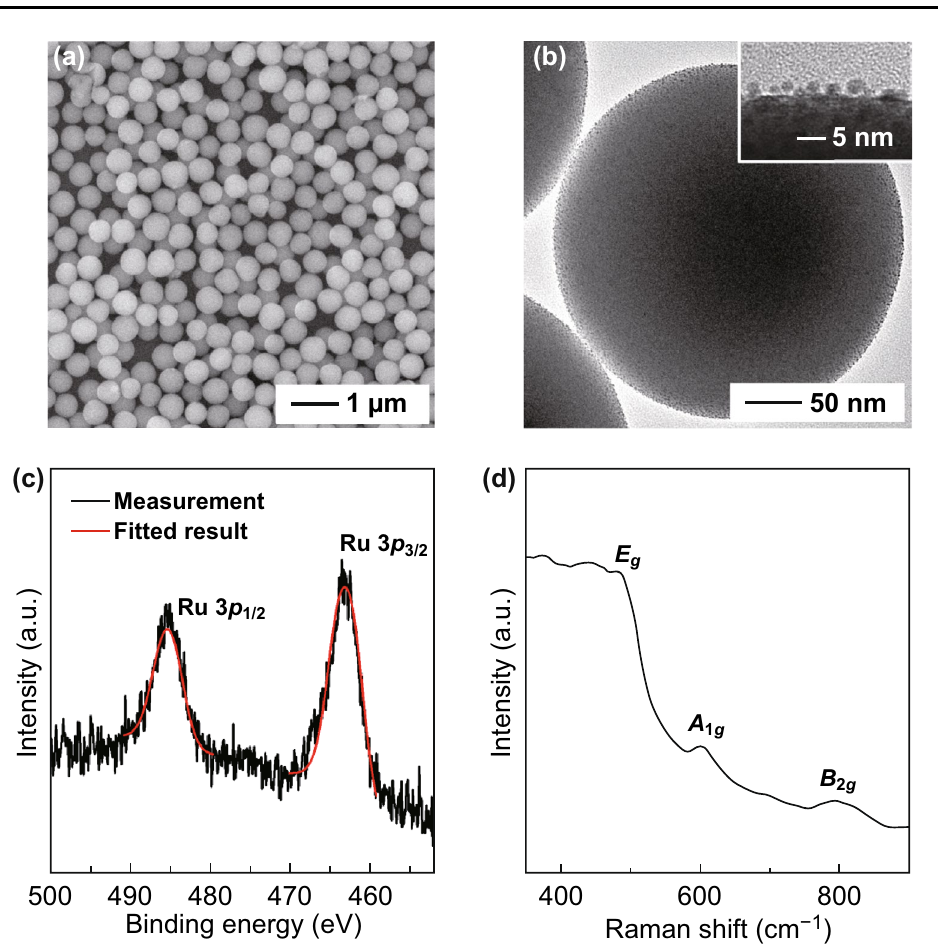
Fig. 1 a SEM image of RuOOH/SiO x composite particles. b TEM image of an individual RuOOH/SiO x composite particle, showing good dis- persion of the RuOOH NPs uniformly distributed on the surface of the SiO x NS. The inset of a blow-up TEM image highlights the well-defined and separated RuOOH NPs with diameters in the range of 2–3 nm. c Experimentally measured (black) and fitted (red) XPS spectrum of the Ru 3p peaks for the RuOOH/SiO x composite particles. d Typical Raman spectrum of the RuOOH/SiO x composite particles. (Color figure online)